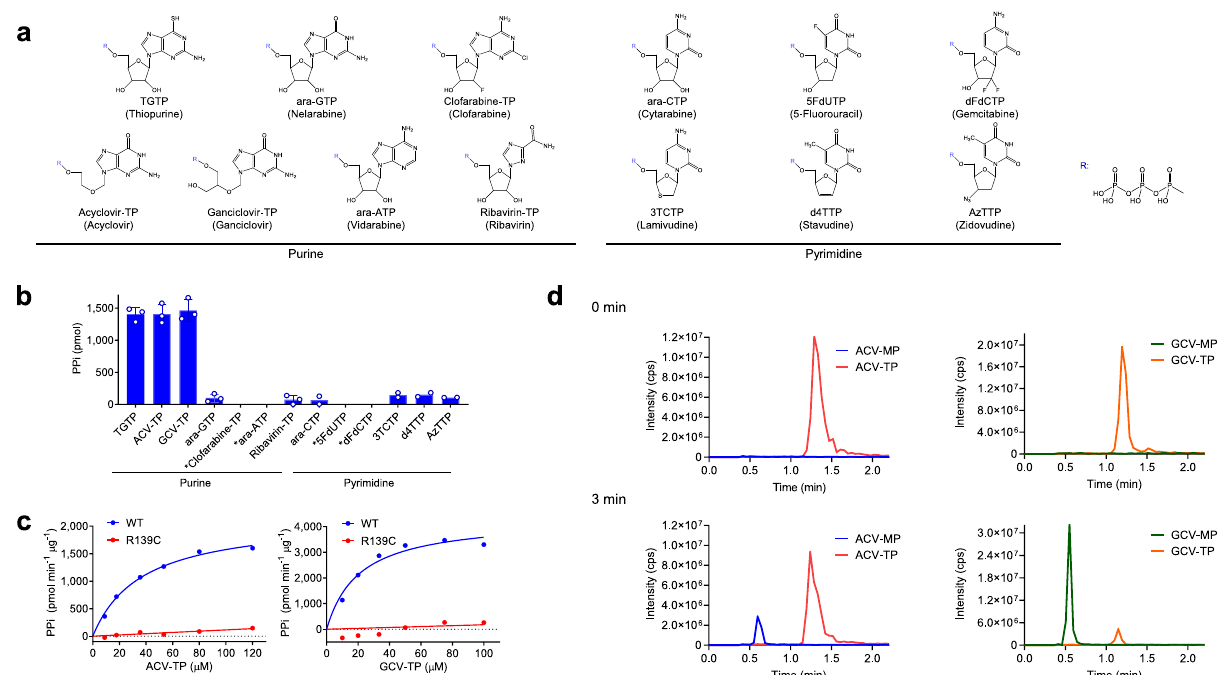
Fig. 1 NUDT15 diphosphatase activity on nucleotide analogs. a Twelve nucleotide analogs were tested for their reactivity with NUDT15, with TGTP (triphosphate nucleotide metabolite of thiopurine) as the reference. Corresponding prodrug names are shown below each metabolite in parenthesis. b Wild-type (WT) NUDT15 protein (200 ng) was incubated with various nucleotide analogs for 10 min followed by measuring released pyrophosphate (PPi) to evaluate the diphosphatase activity. Asterisks denote the value was below the detection limit. Data represent the mean of three replicates; error bars, s. d. c WT NUDT15 or p. R139C variant protein was subjected to diphosphatase activity measurement with acyclovir triphosphate (ACV-TP) or ganciclovir triphosphate (GCV-TP) as the substrate. NUDT15 p.R139C resulted in complete loss of enzymatic activity on both substrates. Data represent the mean of duplicates and experiments were repeated three times. d WT NUDT15 protein (200 ng) was incubated with 50 μ M of either ACV-TP or GCV-TP for 3 min, and reaction samples were analyzed by the UPLC-MS/MS system. Representative data from three biological replicates are shown. ACV-TP and GCV-TP were converted to the monophosphates, ACV-MP and GCV-MP, respectively. Source data for b , c , and d are provided as a Source Data fi le.